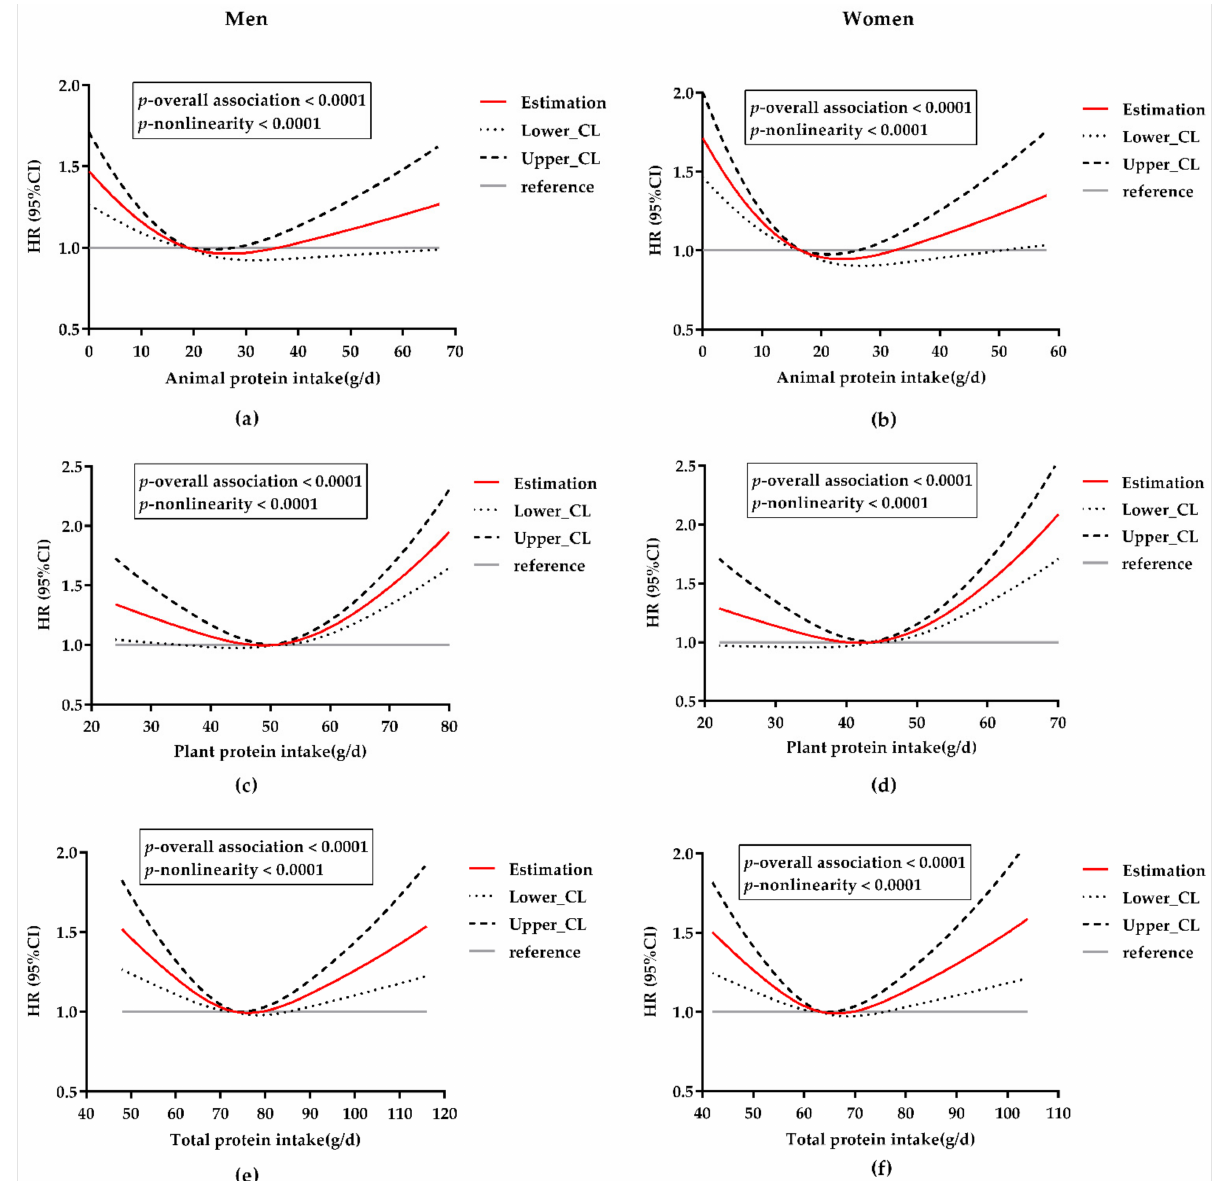
Figure 2. Multivariable-adjusted HRs and 95% CIs for the risk of HT according to dietary intakes of animal, plant, and total protein on a continuous scale. CI, confidence interval; CL, confidence limit; HT, hypertension. ( a ) Association between animal protein intake and HT risk in men; ( b ) Association between animal protein intake and HT risk in women; ( c ) Association between plant protein intake and HT risk in men; ( d ) Association between plant protein intake and HT risk in women; ( e ) Associa- tion between total protein intake and HT risk in men; ( f ) Association between total protein intake and HT risk in women. Red solid lines represent the multivariable-adjusted HRs, with black dotted lines representing the 95% CIs. Gray horizontal solid lines represent the references that were set at the median intakes, corresponding to an HR of 1.0. Analyses were adjusted for a series of variables according to Model